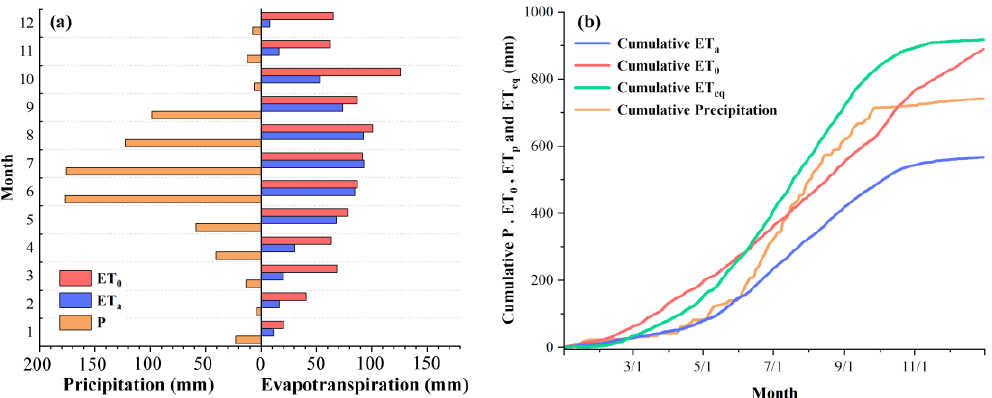
Figure 7. ( a ) Seasonal variation in evapotranspiration and precipitation in the alpine swamp meadow. ( b ) Cumulative reference evapotranspiration (ET 0c ), cumulative actual evapotranspiration (ET ac ), cumulative equilibrium evapotranspiration (ET eqc ), and cumulative precipitation (P c ).